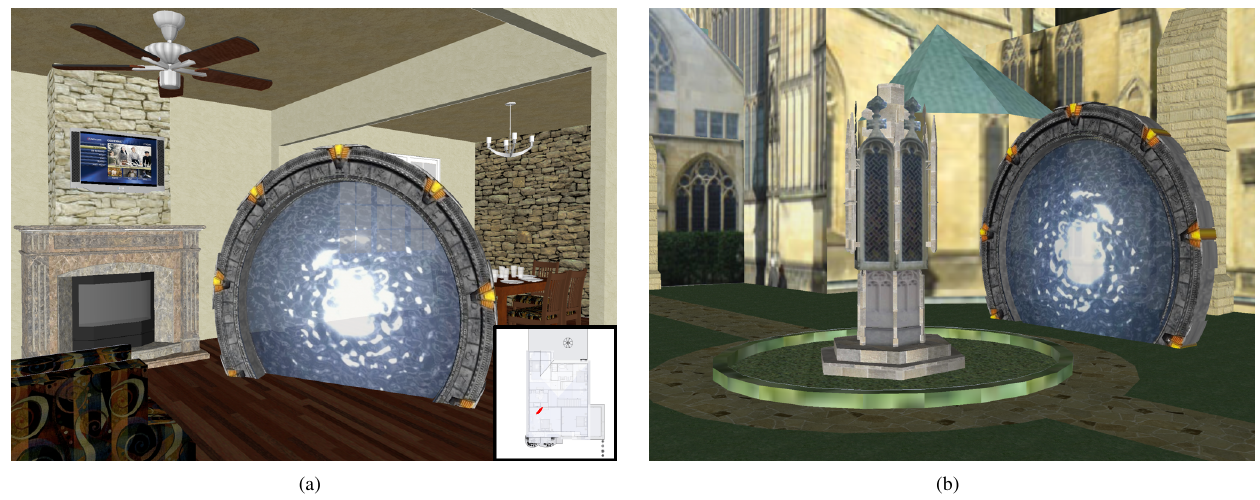
Fig. 2. Illustration of two connected portals: (a) portal displayed in a building with a 2D map of the environment, and (b) the target portal outside the